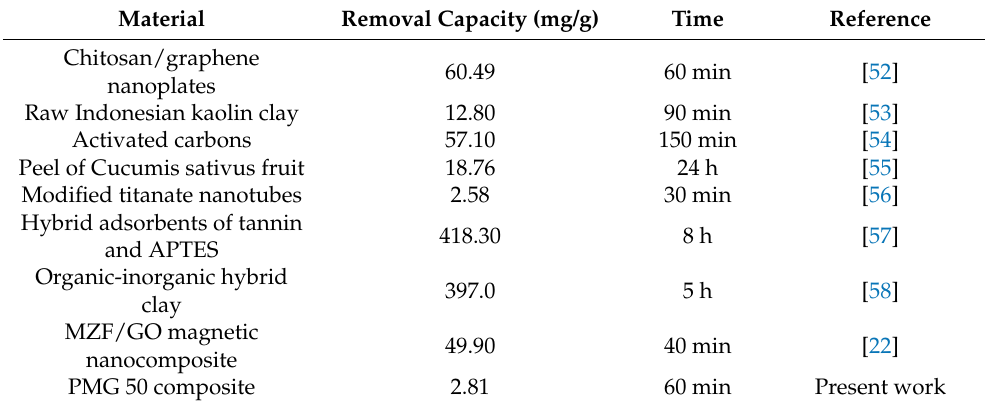
Table 3. Removal capacity and time for adsorption removal of AR1 dye using various